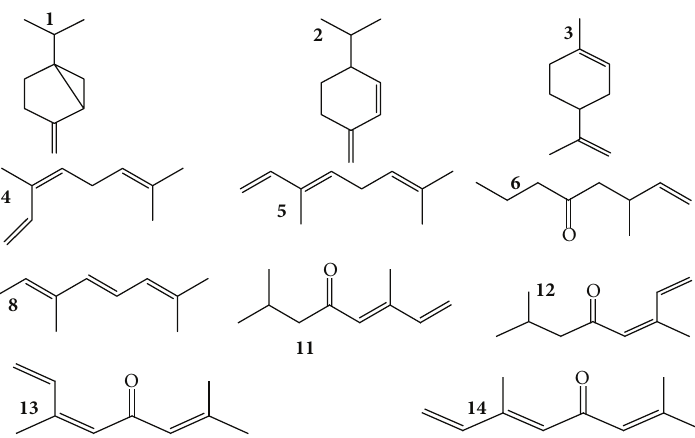
Figure 4: Chemical structures of monoterpenes identified in Tagetes minuta essential oils. ( 1 ) Sabinene, ( 2 ) 𝛼 -phellandrene, ( 3 ) limonene, ( 4 ) (Z)- 𝛽 -ocimene, ( 5 ) (E)- 𝛽 -ocimene, ( 6 ) dihydrotagetone, ( 8 ) alloocimene, ( 11 ) (Z)-tagetone, ( 12 ) (E)-tagetone, ( 13 ) (Z)-ocimenone, and ( 14 ) (E)-ocimenone. Table 3: Minimum inhibitory concentrations and minimum bactericidal concentrations of essential oils of Tagetes minuta on three plant pathogenic bacteria. EOs concentration Tube/plate number (mg/mL) ∗ 10 2